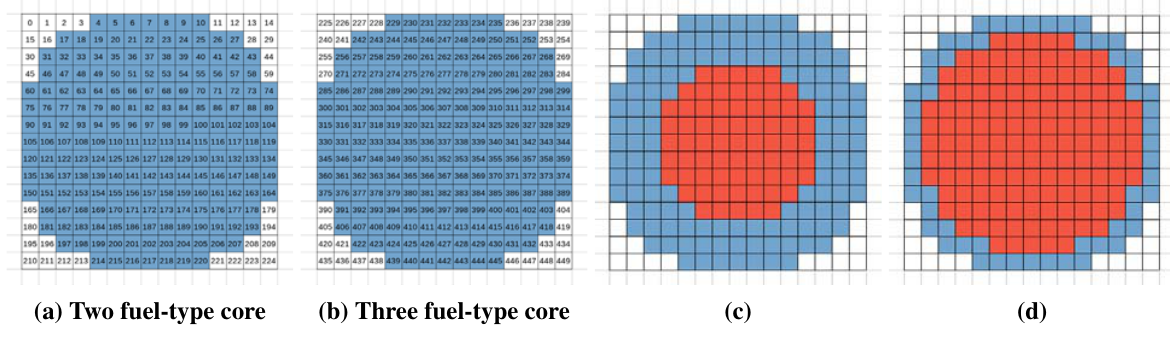
Figure 1: Core representation with qubits on a regular grid (a, b) and examples of transverse fields, h , defining inner and outer regions (c,